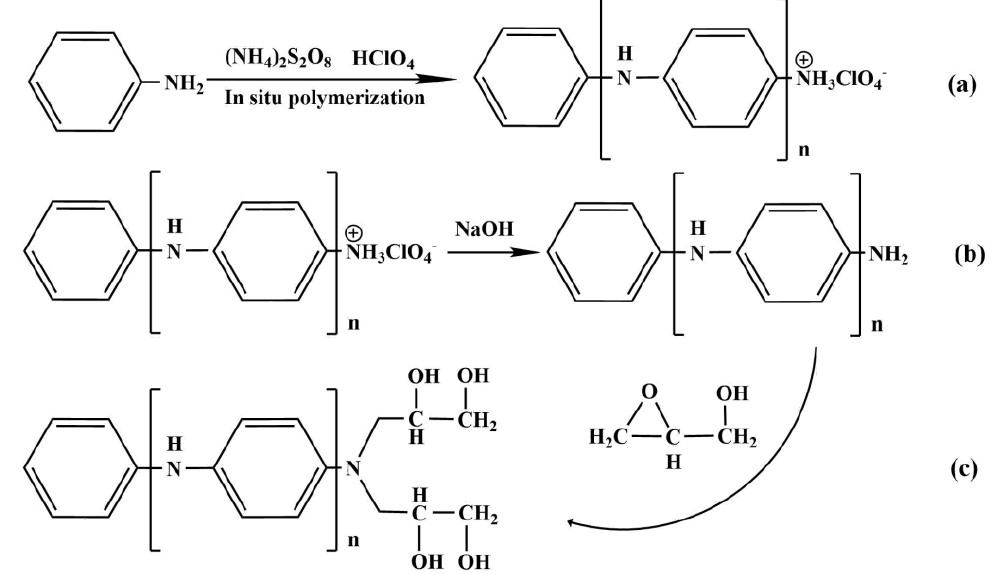
Figure 1. The typical reaction mechanism for the PANI-OH-3 adsorbents. ( a ) In situ polymerization of aniline; ( b ) reducing activity -NH 2 ; ( c ) graft functional group.